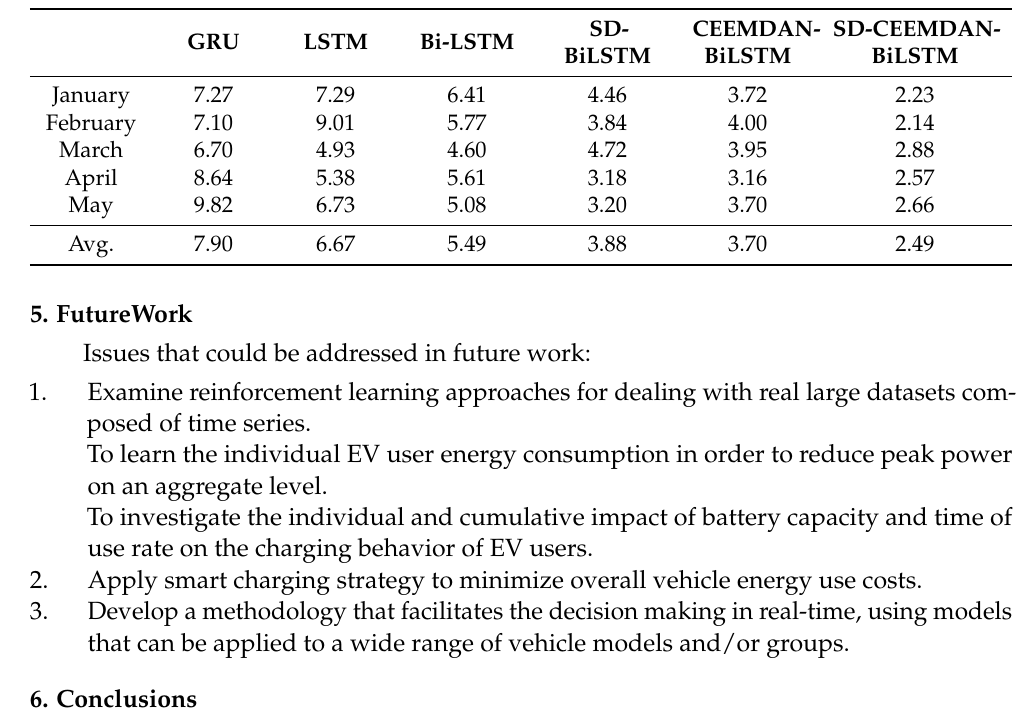
SD- CEEMDAN- BiLSTM